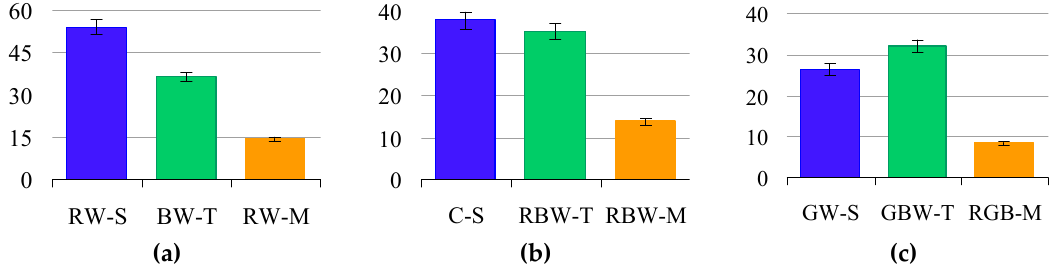
Figure 2. Comparison of PLB production for the ( a ) highest ( b ) second highest and ( c ) third highest CHO source –LED combination within each CHO source. The X-axis the treatment combination, the Y-axis represents the number of PLBs, and the error bar represents the 95% confidence intervals. See text for meanings of abbreviations.